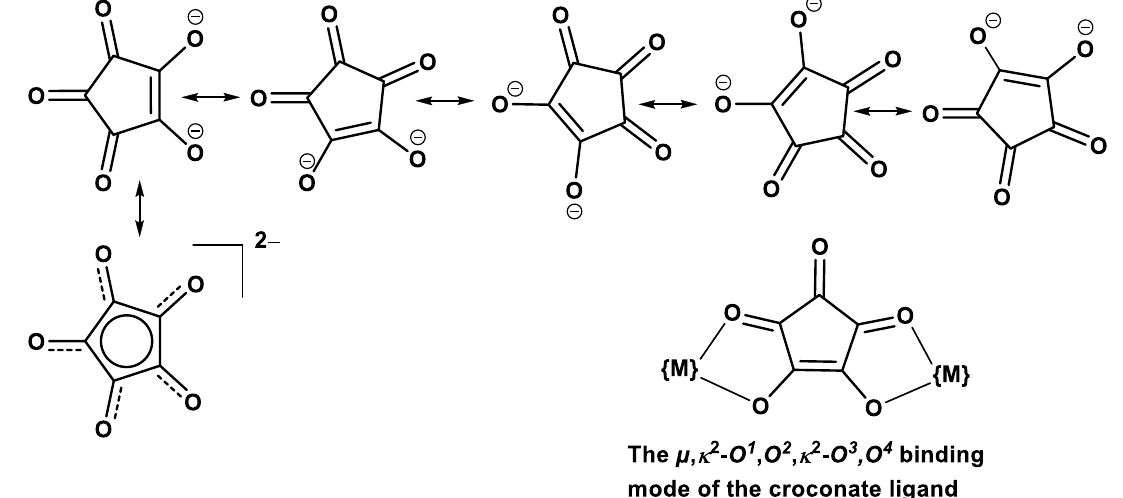
Figure 2. Resonance structures for the croconate dianion and its envisioned bis(chelating) binding mode for providing metallamacrocyclic structures.